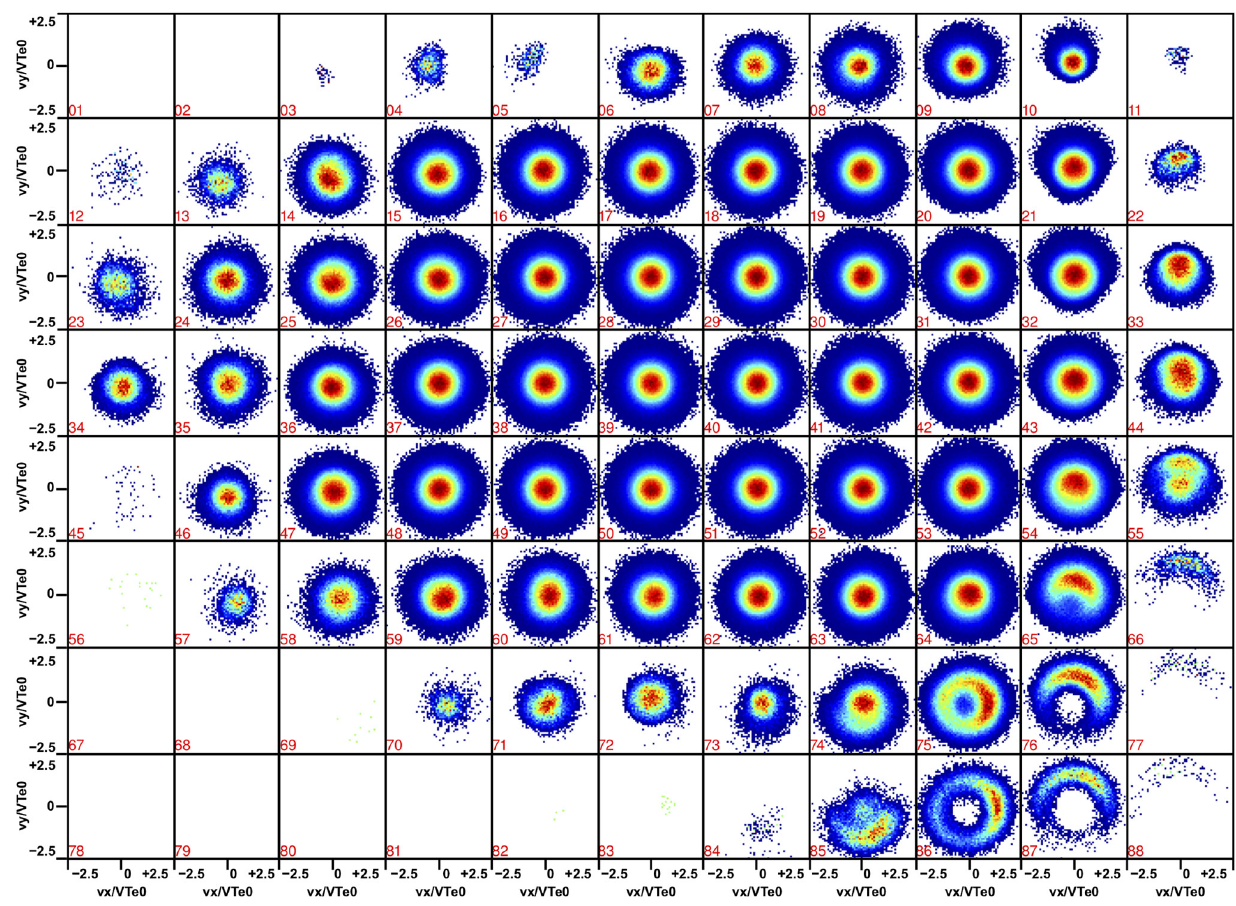
Figure A2. Electron VDFs, at t = 1 T Li , for each of the 88 spatial bins defined in Fig. A1a. We show v z = 0 cross sections. The nine VDFs presented in Fig. 2 of the article correspond to bins 39, 10, 21, 43, 65, 76, 87, 75 and